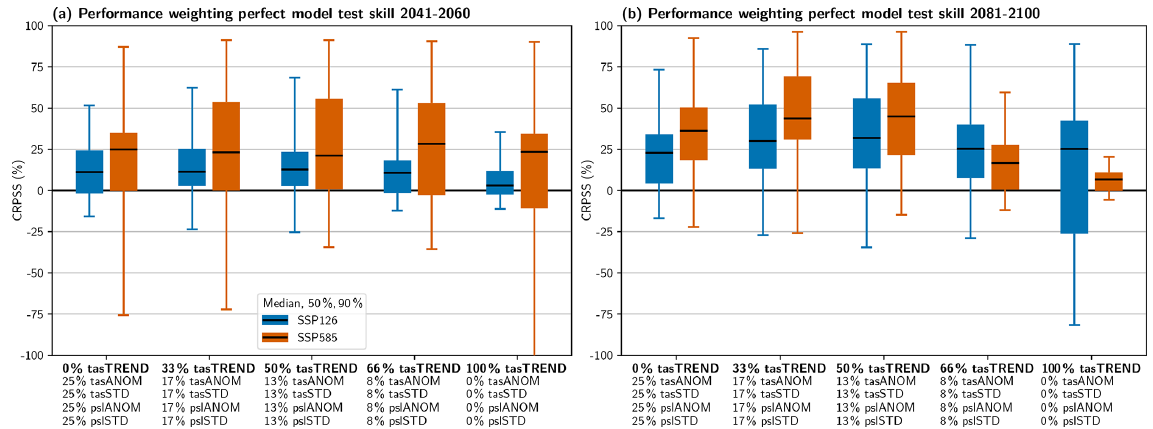
Figure 1. Continuous ranked probability skill score (CRPSS) relative to the unweighted ensemble for the performance weighting based on a leave-one-out perfect model test with CMIP6 for (a) mid-century and (b) end-of-century temperature change relative to 1995–2014. The x axis shows different combinations of the two diagnostic groups ranging from only non-trend-based diagnostics (0% tasTREND) to only trend-based diagnostics (100% tasTREND). The values not summing to 100% is due to rounding in the labels